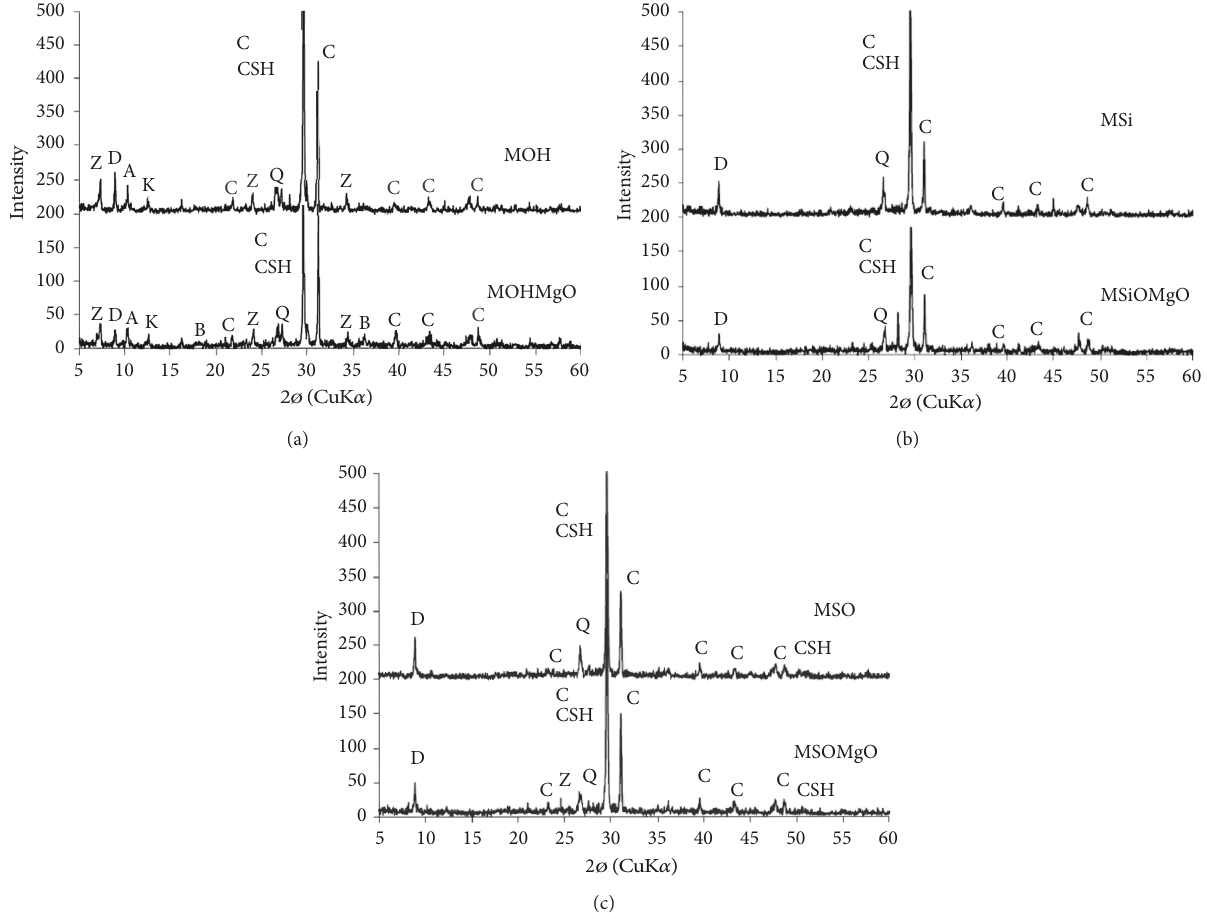
Figure 8: XRD spectra of 28-day old limestone/metakaolin/calcium hydroxide with and without magnesia. C: calcite, Z: zeolite, A: AFM phase, D: additional layered calcium carboaluminate phase, M: muscovite, MI: mica, Q: quartz, and K: